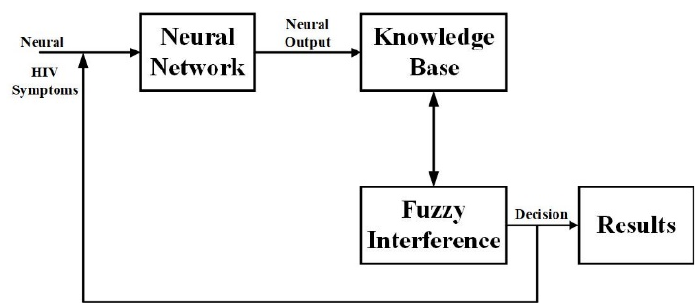
Figure 5. Nero-fuzzy system model.